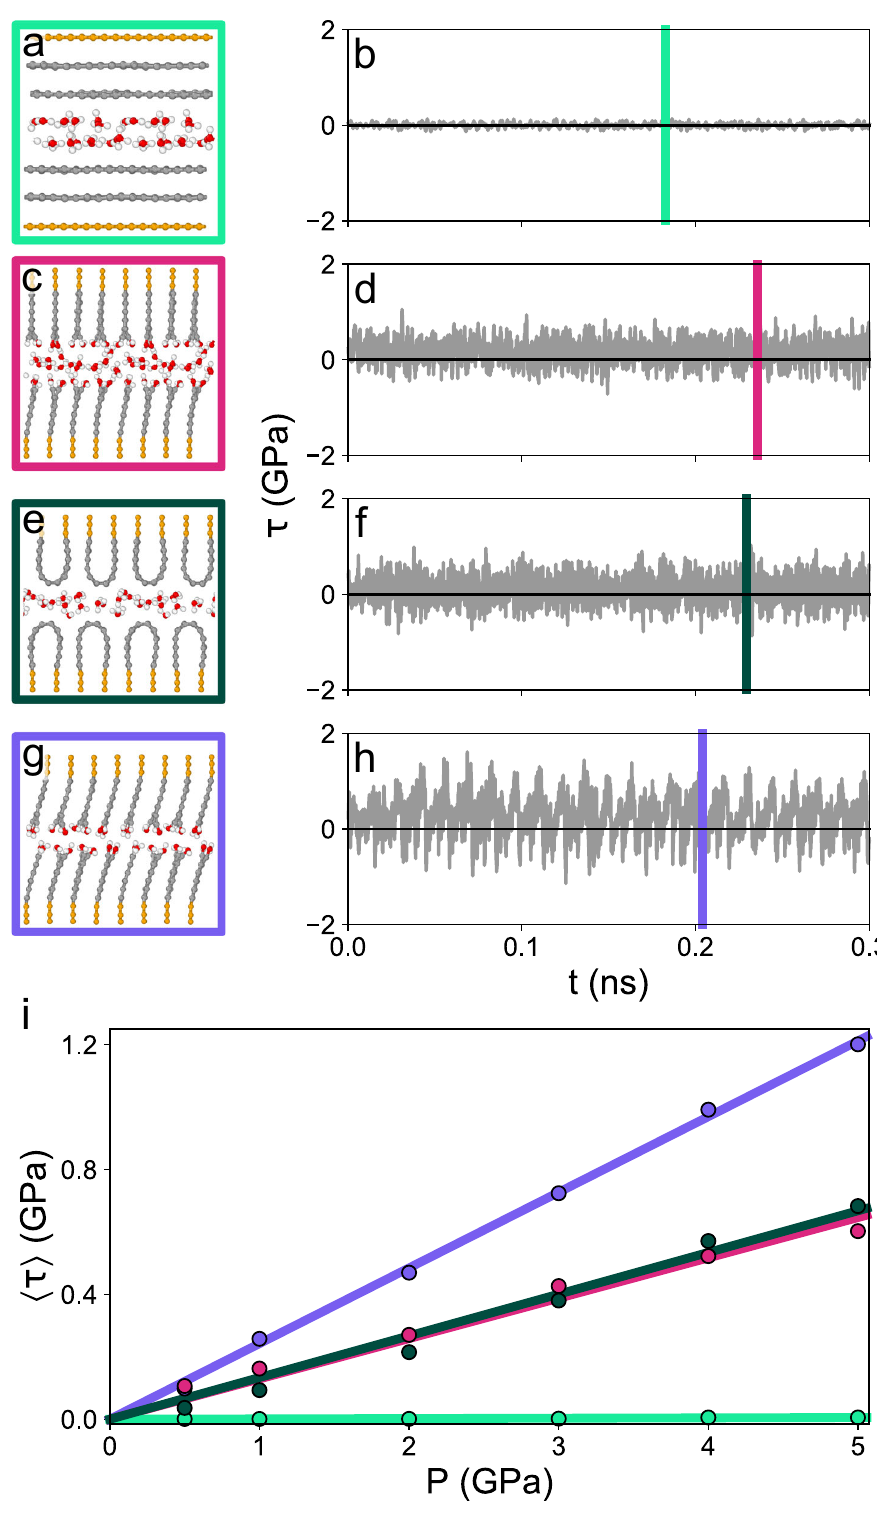
e , f Loops formed from initially unpassivated perpendicular graphite sliding with n H 2 O =16. g , h DryslidingofmixedH/OHpassivatedgraphite. i Averageshearstress 〈 τ 〉 as a function of normal pressure P for the systems in a – h . Color codes refer to the color of the boxes surrounding snapshots. Straight lines are linear fi ts to the =16. simulation 2 O =16). 2 O